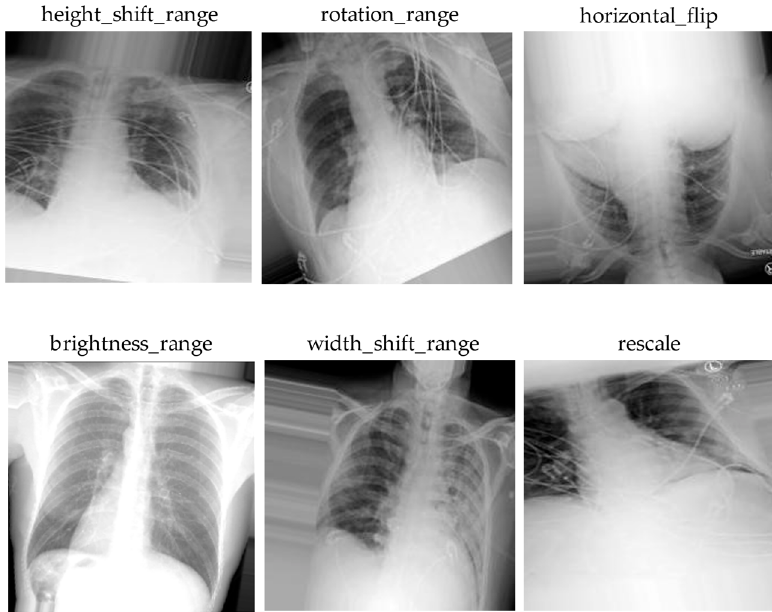
Figure 4. Image samples after applying augmentation techniques.